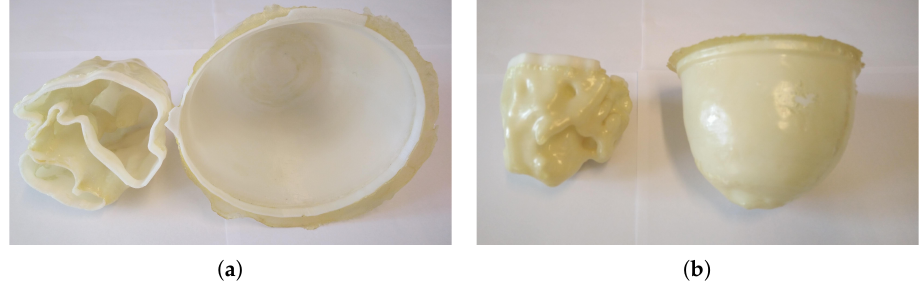
Figure 2. The two shells of the GeePS-L2S phantom: ( a ) a top-down view; and ( b ) a view from the side. To the left is the inner fibroglandular shell. To the right is the outer adipose shell.